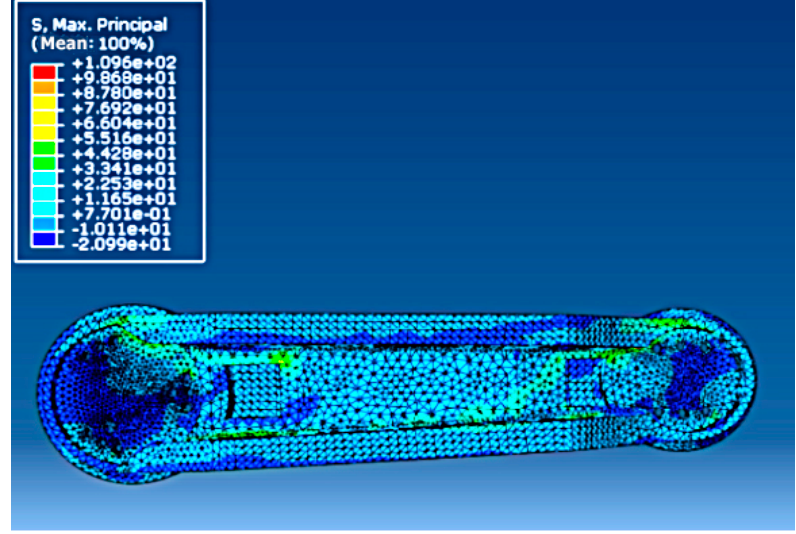
Figure 11. Maximum tensile stress distribution in the most unfavorable working condition.